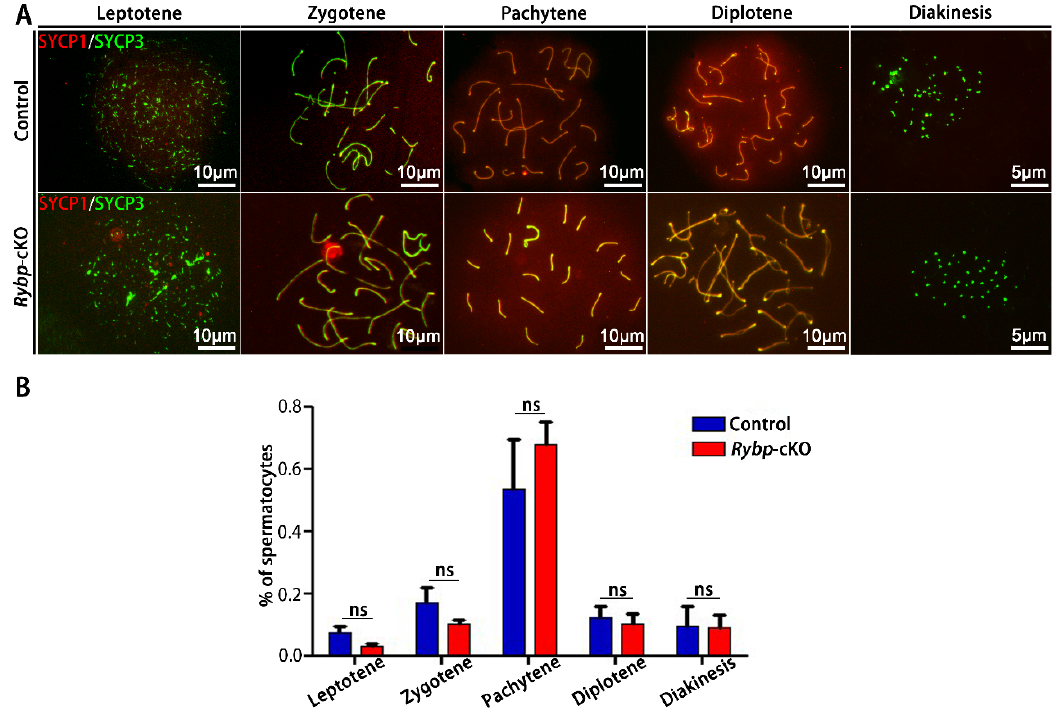
Figure 4. Germ-cell-specific deletion of Rybp did not affect meiosis. ( A ) Coimmunostaining of SYCP3 and SYCP1 in spermatocytes from male postnatal day 21 (PD21) control and Rybp -cKO mice. ( B ) Composition of the spermatocyte population in control and Rybp -cKO spermatocytes. Data were analyzed using mean ± SEM for three mice per genotype. ns: indicates no difference.